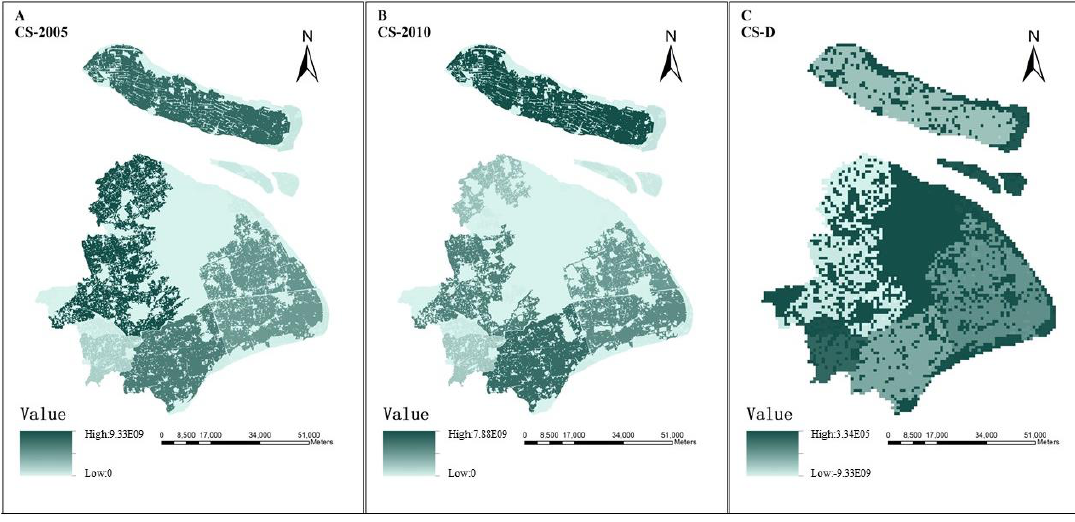
Figure 8. Spatial and temporal change of soil conservation service in Shanghai (sej/yr). ( A ) spatial distribution of SC in 2005; ( B ) spatial distribution of SC in 2010; ( C ) spatial change of SC.